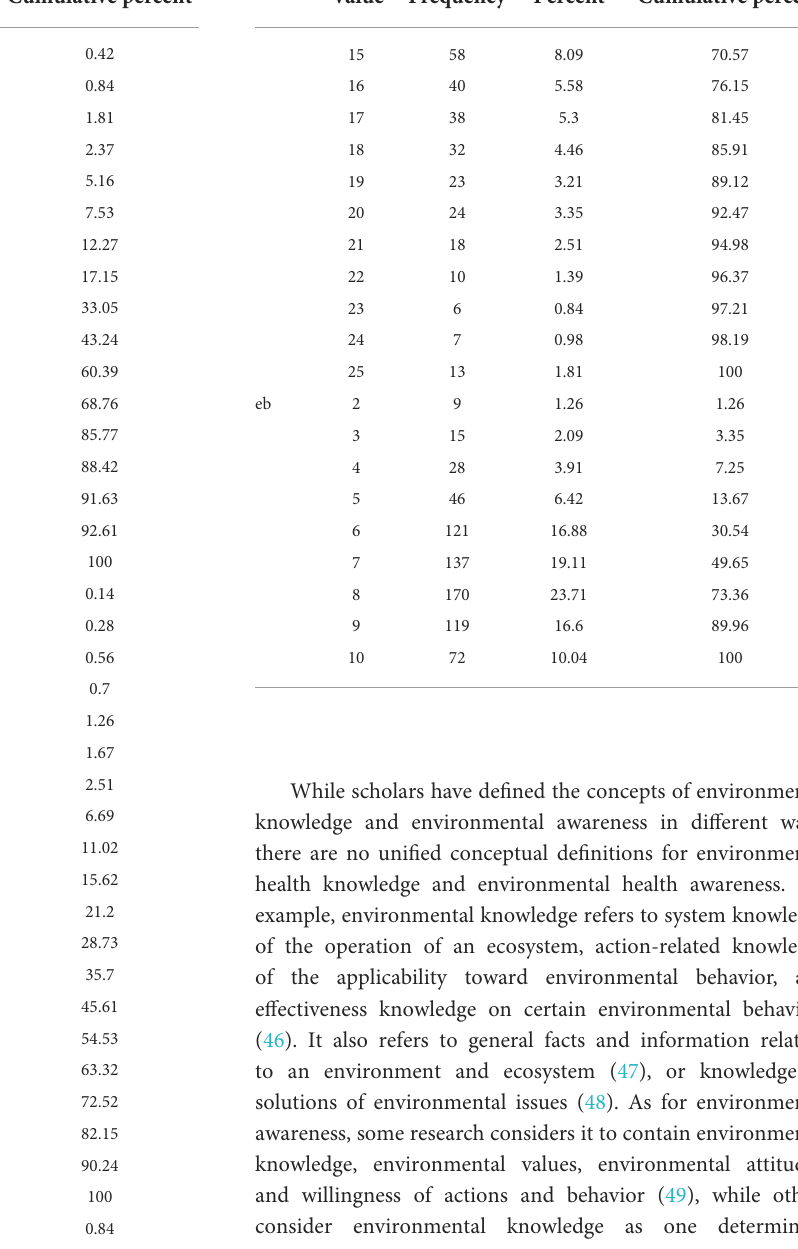
TABLE 2 Frequency distribution of kernel